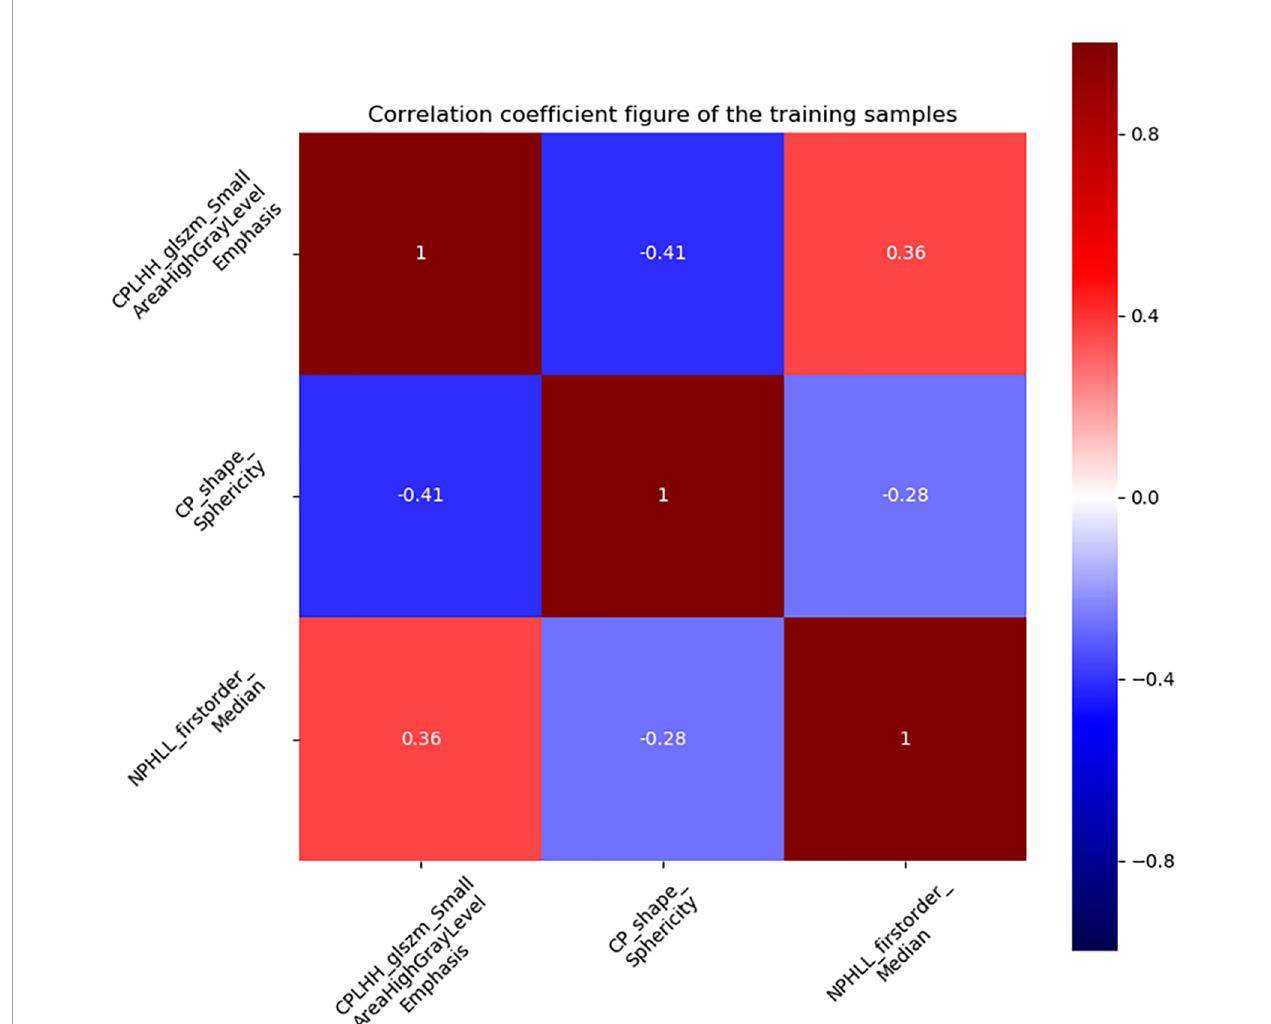
FIGURE 4 | The correlation diagram of the three effective features screened